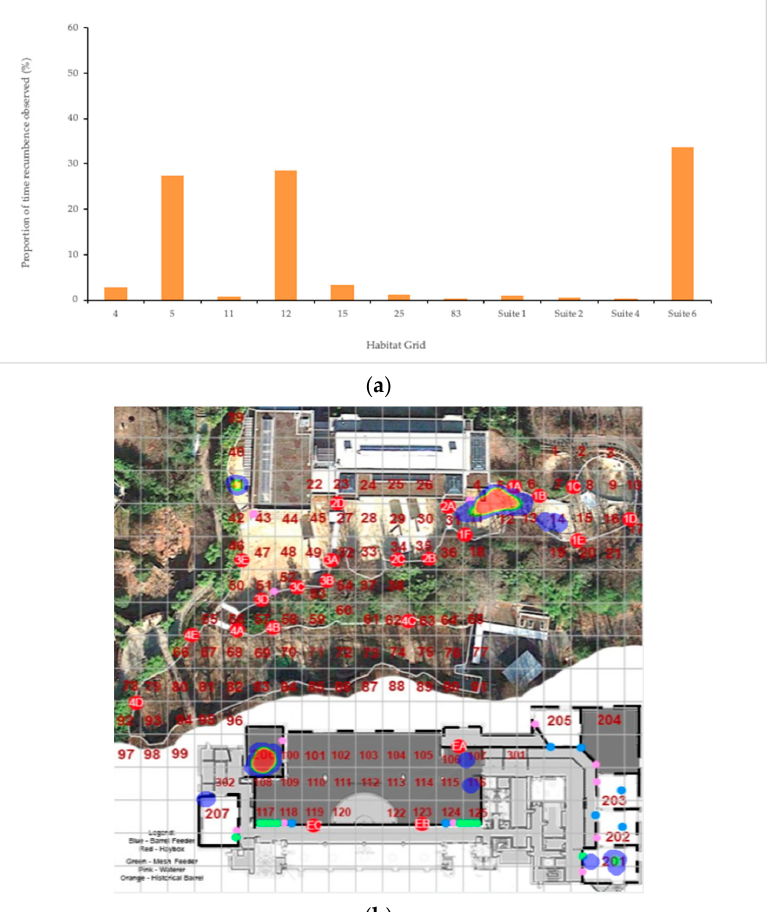
Figure 9. Heat map of behavior observations from ( a ) 24 h interval data and ( b ) ZooMonitor 30 min focal observations indicate that the bull elephant exhibits a preference in areas used to exhibit “Recumbence” or lay down. In ( b ), the red areas indicate more frequently observed behaviors, in this case, recumbence. Circles of various colors denote exhibit food/water features.